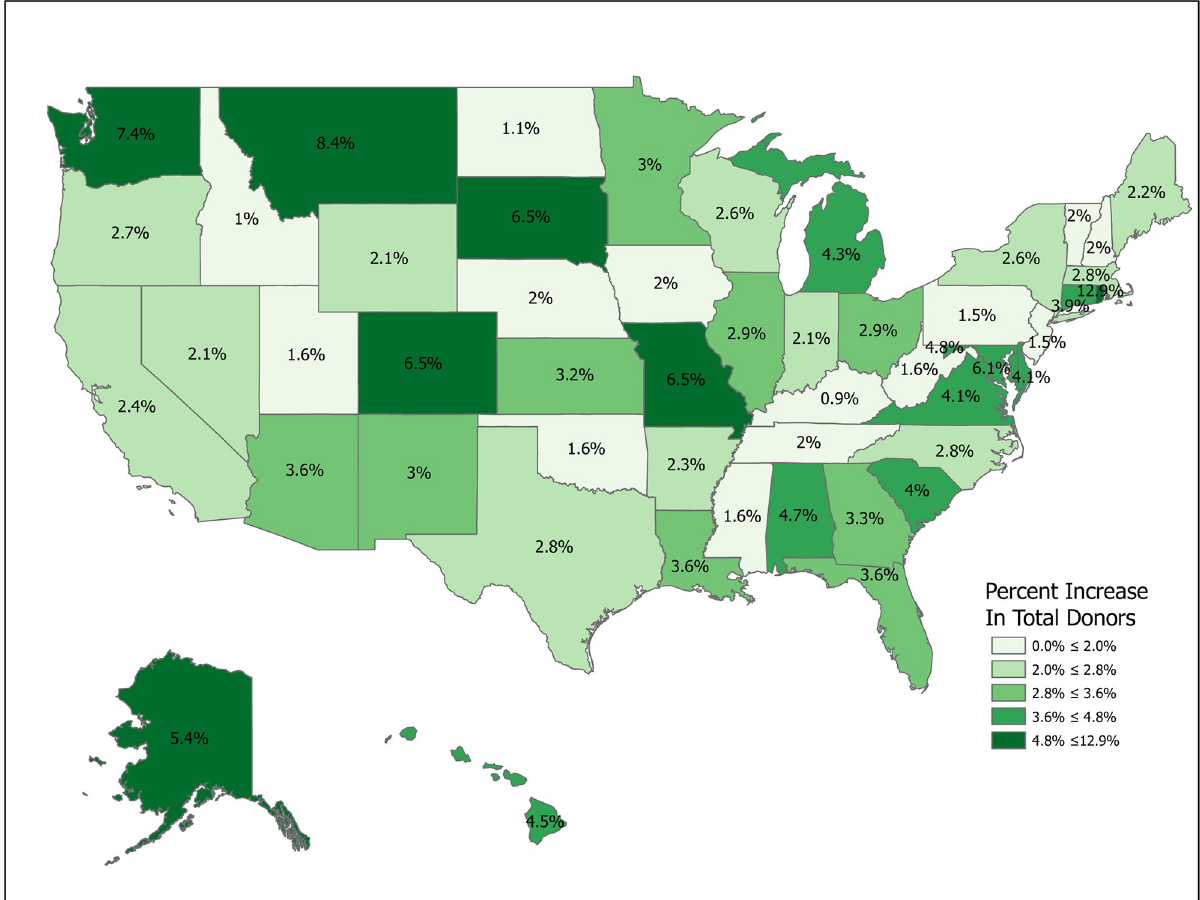
Fig 7. Simulation 1: Increase registration rates by 10 percent in each state. Data come from Table 6. Maps created by ArcGIS Pro, URL: https://www. esri.com/en-us/arcgis/products/arcgis-pro/overview. Base Map: World Light Gray Base, URL: https://services.arcgisonline.com/arcgis/rest/services/